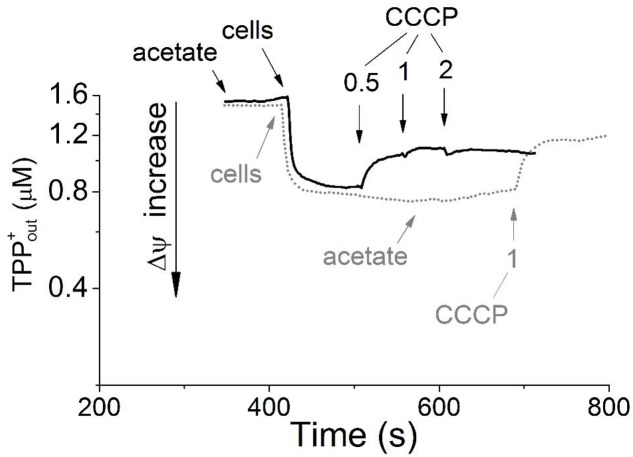
Generation of transmembrane electrical potential in aerobically grown resting cells of Melioribacter roseus. The incubation medium (pH 7.0) was the same as the growth medium with the exception that the growth factors were omitted, but TPP-Cl was added to the final concentration of 1.6 μM. Small arrows indicate time points of the following additions to the incubation mixture: the cells to achieve 3 mg ml-1 of total cell protein; sodium acetate to achieve 10 mM final concentration; and CCCP in micromolar concentrations as indicated in the panel. Membrane potential is shown in the intact cells preincubated without acetate before its addition (gray dotted line) and in the cells incubated for 5 min with acetate (black solid line). All measurements were carried out at 52°C.